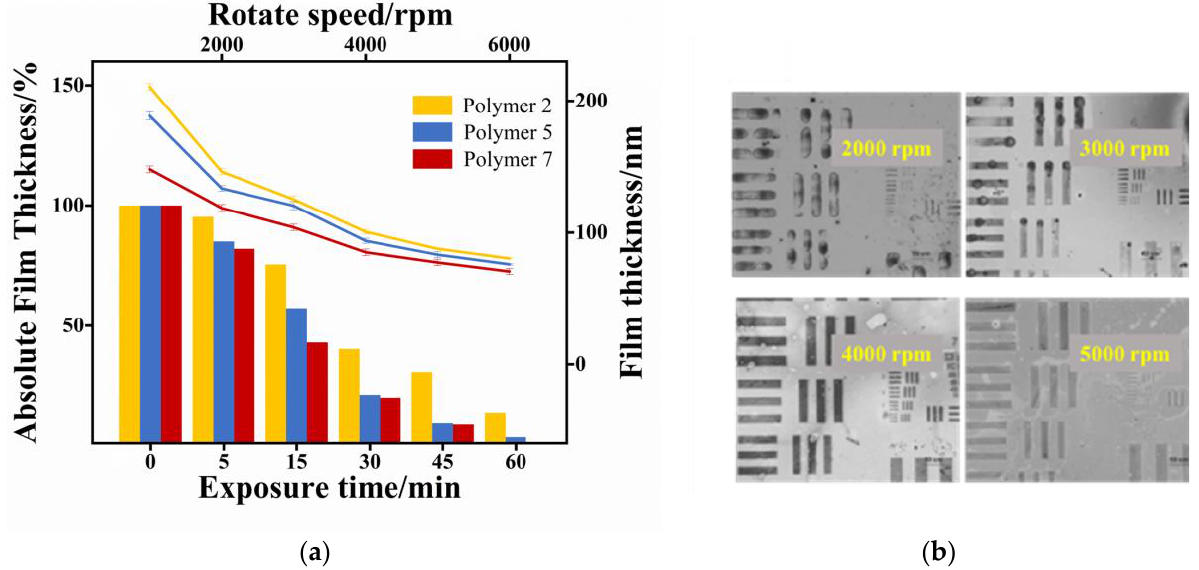
Figure 4. The effect of molecular weight on ( a ) film thickness at different rotation speeds and photosensitivity; ( b ) lithography patterning.